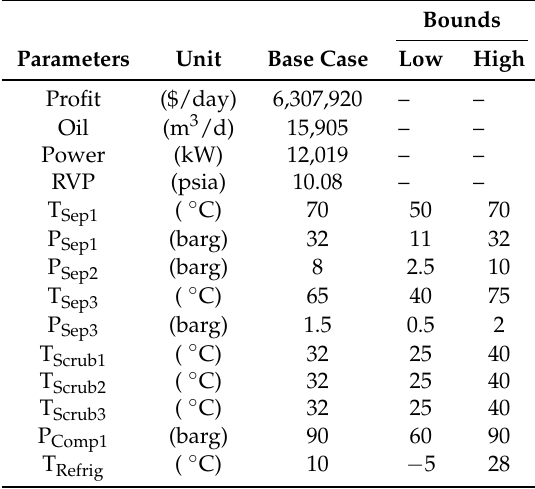
Table 2. Processsimulation parameter settings for base case simulations. The gas export pressure was set to 188 barg for all